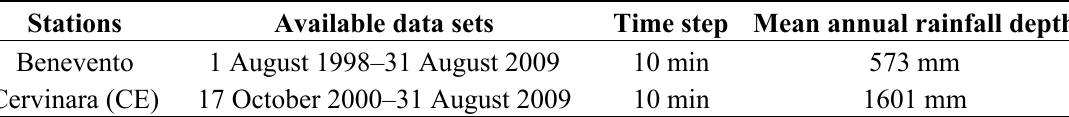
Table 2. Characteristics of the rainfall series